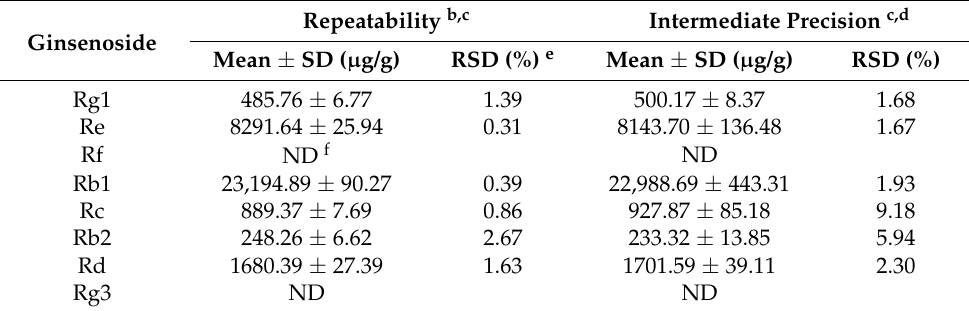
Table 4. Repeatability and intermediate precision of ginsenosides by HPLC-DAD-ESI-MS a .